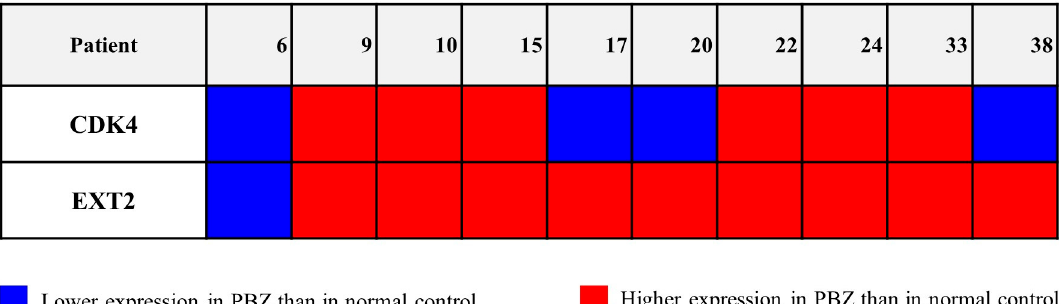
Figure 2. CDK4 and EXT2 expression levels in the peritumoural biopsy (PBZ) of each patient. Blue, indicates a lower expression of the target gene in the PBZ compared with the control; red, indicates a higher expression of the target gene in the PBZ compared with the control. Normal human astrocytes (NHA) cells are used as the control.